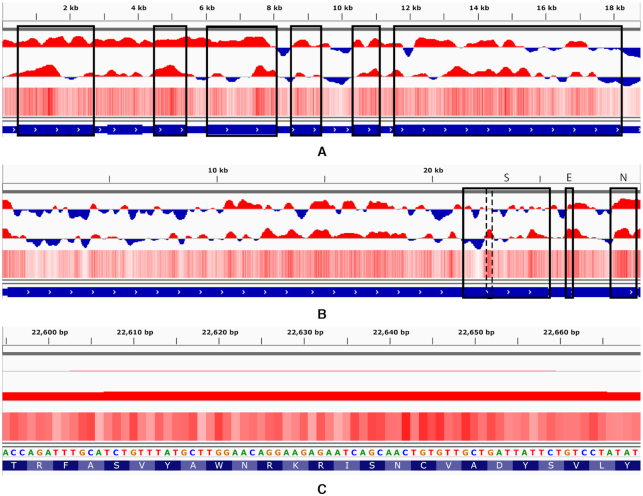
Taï Forest ebolavirus and SARS-CoV-2 coronavirus genomes. Top: score predicted by LSTMAll. Middle: score predicted by CNNAll. Heatmap: nucleotide contributions of CNNAll. Bottom, in blue: reference sequence. (A) Taï Forest ebolavirus. Genes that can be detected by at least one model are highlighted in black. (B) Whole genome and sequences encoding the spike protein (S), envelope protein (E) and nucleocapsid protein (N). (C) Spike protein gene, a small peak (positions 22 595–22 669, dashed line in Figure 2B) within the receptor-binding domain (predicted by CD-search, positions 22 517–23 185). Binding to the receptor is crucial for entry to the host cell. Local host adaptation could help switch hosts between the animal reservoir and humans.